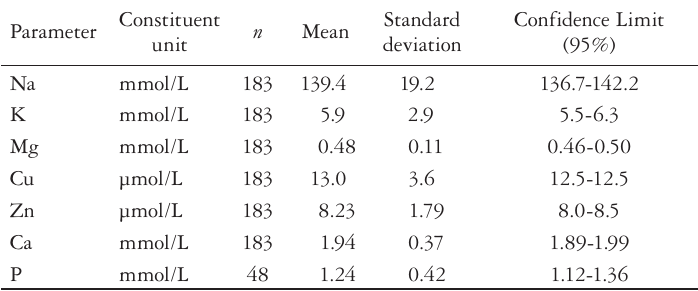
Table 3. Serum mineral levels in free-ranging red deer ( Cervus elaphus atlanticus)